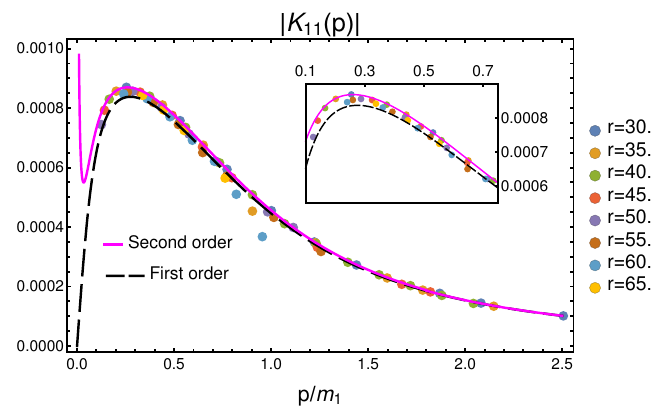
Figure 2 . Perturbative predictions against the TCSA data for the two-particle overlap K 11 as a function of the dimensionless momentum p 1 /m after a quench of size ξ = ( h The overlap was determined by TCSA using volumes m 1 R = 30 . . . 65 , as the colours indicate. Dashed lines correspond to the first-order predictions, and continuous lines depict the sum of first two orders. The inset shows that adding the for this small